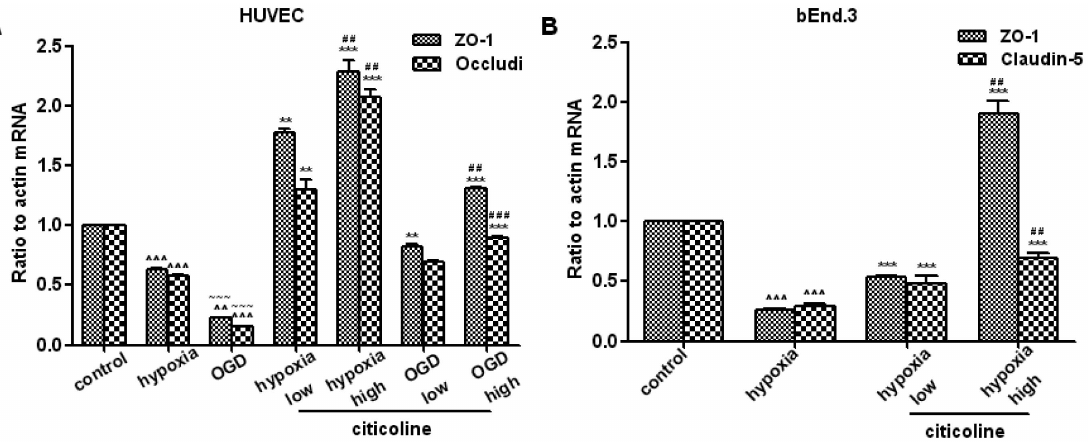
Figure 3. The effects of citicoline on Hypoxia/OGD induced changes in the mRNA level of TJPs in endothelial cells. ( A ) mRNA level of ZO-1 and occludin in HUVECs. ( B ) mRNA levels of claudin-5 and ZO-1 in bEnd.3s. Both high and low dose of citicoline increase the expression, while high-dose is more effective when compared to low dose.ˆˆ P , 0.01,ˆˆˆ P , 0.001 vs. control; * P , 0.05, ** P , 0.01, *** P , 0.001 vs. model; ## P , 0.01, ### P , 0.001 vs. low citicoline; ,,, P , 0.001 vs. hypoxia,